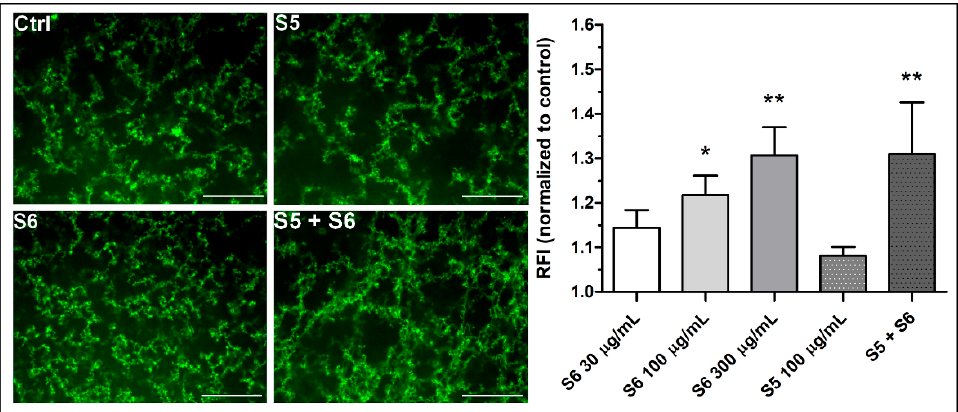
Figure 4. Confocal microscopy and analysis of the relative fibrin clot density. Samples of pure human fibrinogen supplemented with AF488-labelled human fibrinogen (to visualize fibrin) were incubated for 10 min with fractions S6 (30–300 µg/mL) or S5 (100 µg/mL) or with their combinations (300 µg/mL + 100 µg/mL of S6 and S5, respectively). Control samples were supplemented with saline. Clotting was triggered by bovine thrombin. After the gelation point (2h), the clots were analyzed using confocal microscope. Representative fibrin strands from 5 independent experiments are presented. Relative fluorescence intensity (RFI, fluorescence of fibrin in the studied sample in relation to fluorescence of fibrin in the control) was used as a measure of the content of fibrinogen molecules in the analyzed clots, i.e., the extent of polymerization. * p < 0.05; ** p < 0.01, n = 5. The scale bar represents 30 µm.